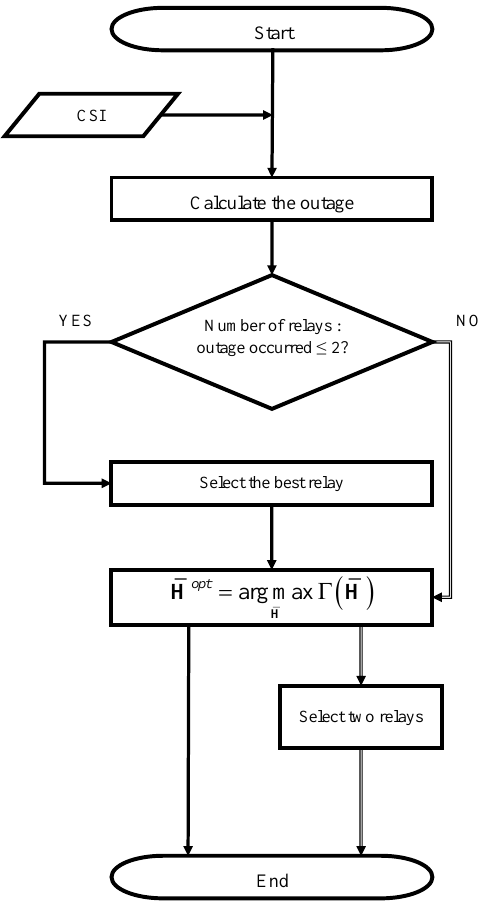
Figure 2. Flow chart of the proposed